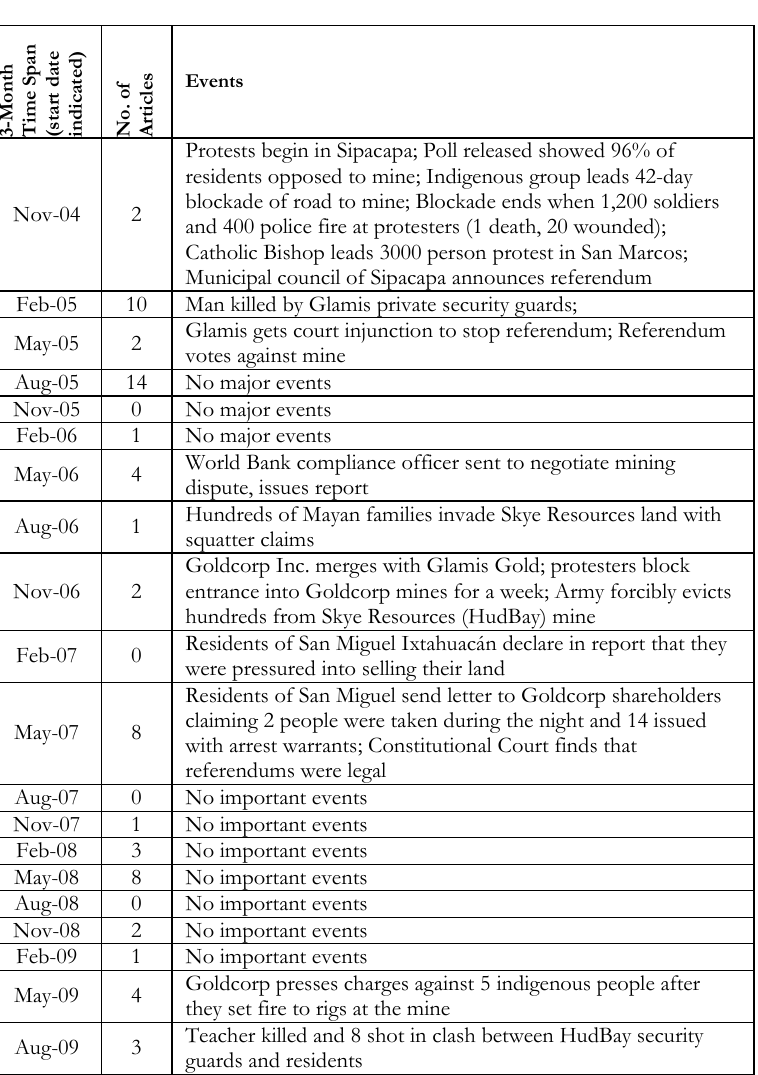
Table 1: Timeline of anti-mine protests in Guatemala and related events,